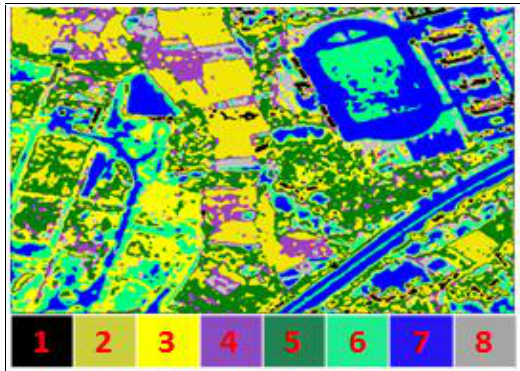
Figure 9. The dual-antennas XSAR system